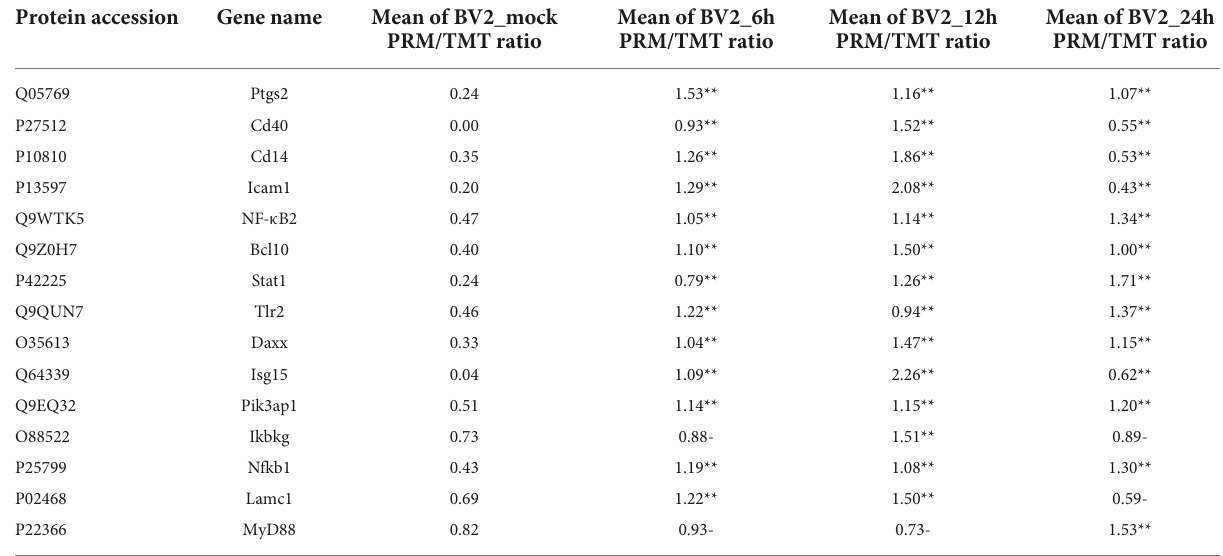
TABLE 1 PRM validation of the proteomics. Protein